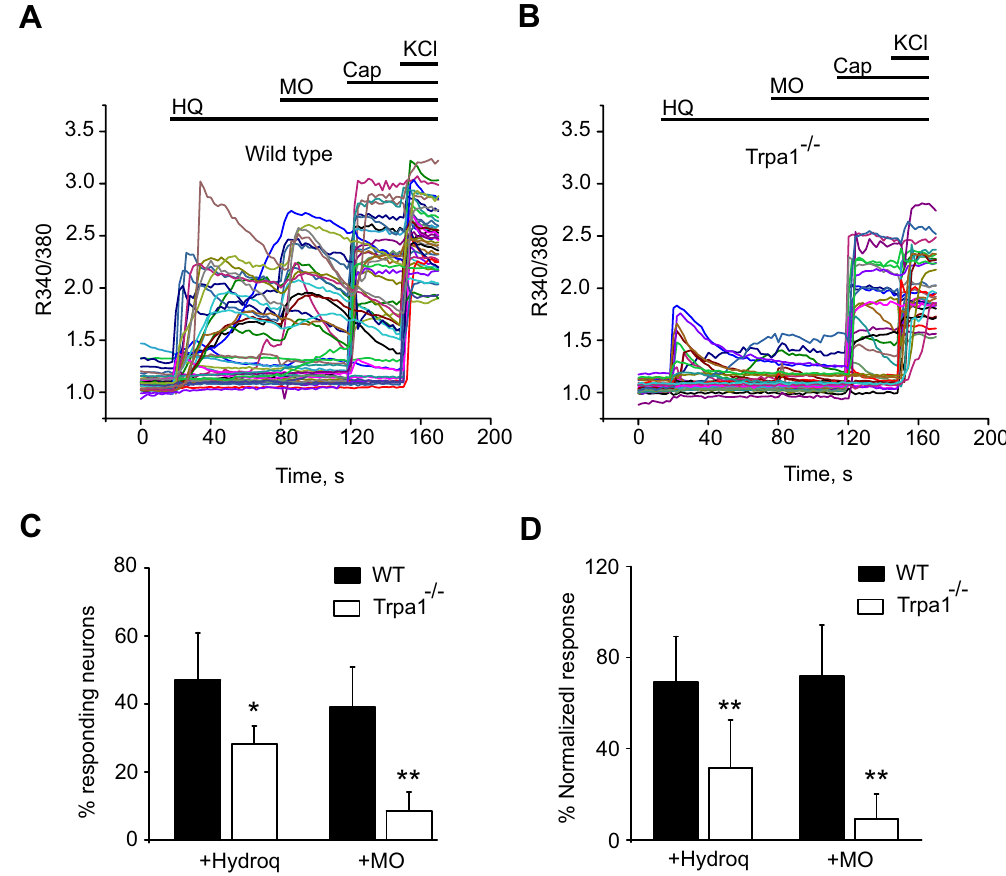
Figure 6. HQ activates TRPA1 in mouse sensory neurons. ( A ) Representative pseudo-color images of the effect of HQ (30 µ M) on intracellular Ca 2 + of cultured DRG neurons isolated from TRPA1 deficient mice. ( B ) Representative Ca 2 + imaging traces showing HQ responses in cultured DRG neurons isolated from Trpa1 − / − mice. Drug dosages and application procedures are the same as in ( A ). ( C ) Averaged percentages of neurons from wild type(WT) or Trpa − / − mice positively responding to HQ and MO. (D) Averaged percent increases of R 340/380 of the Ca 2 + responses to HQ and MO recorded from neurons isolated from WT or Trpa1 − / − mice. n = 5–6 tests/group, each group contains up to 30 neurons. * p < 0.05, ** p <